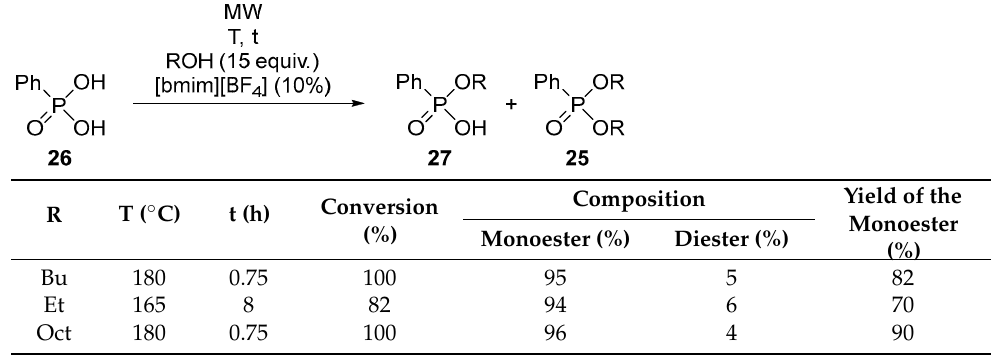
Table 3. MW-promoted direct esterification of phenylphosphonic acid ( 26 ).